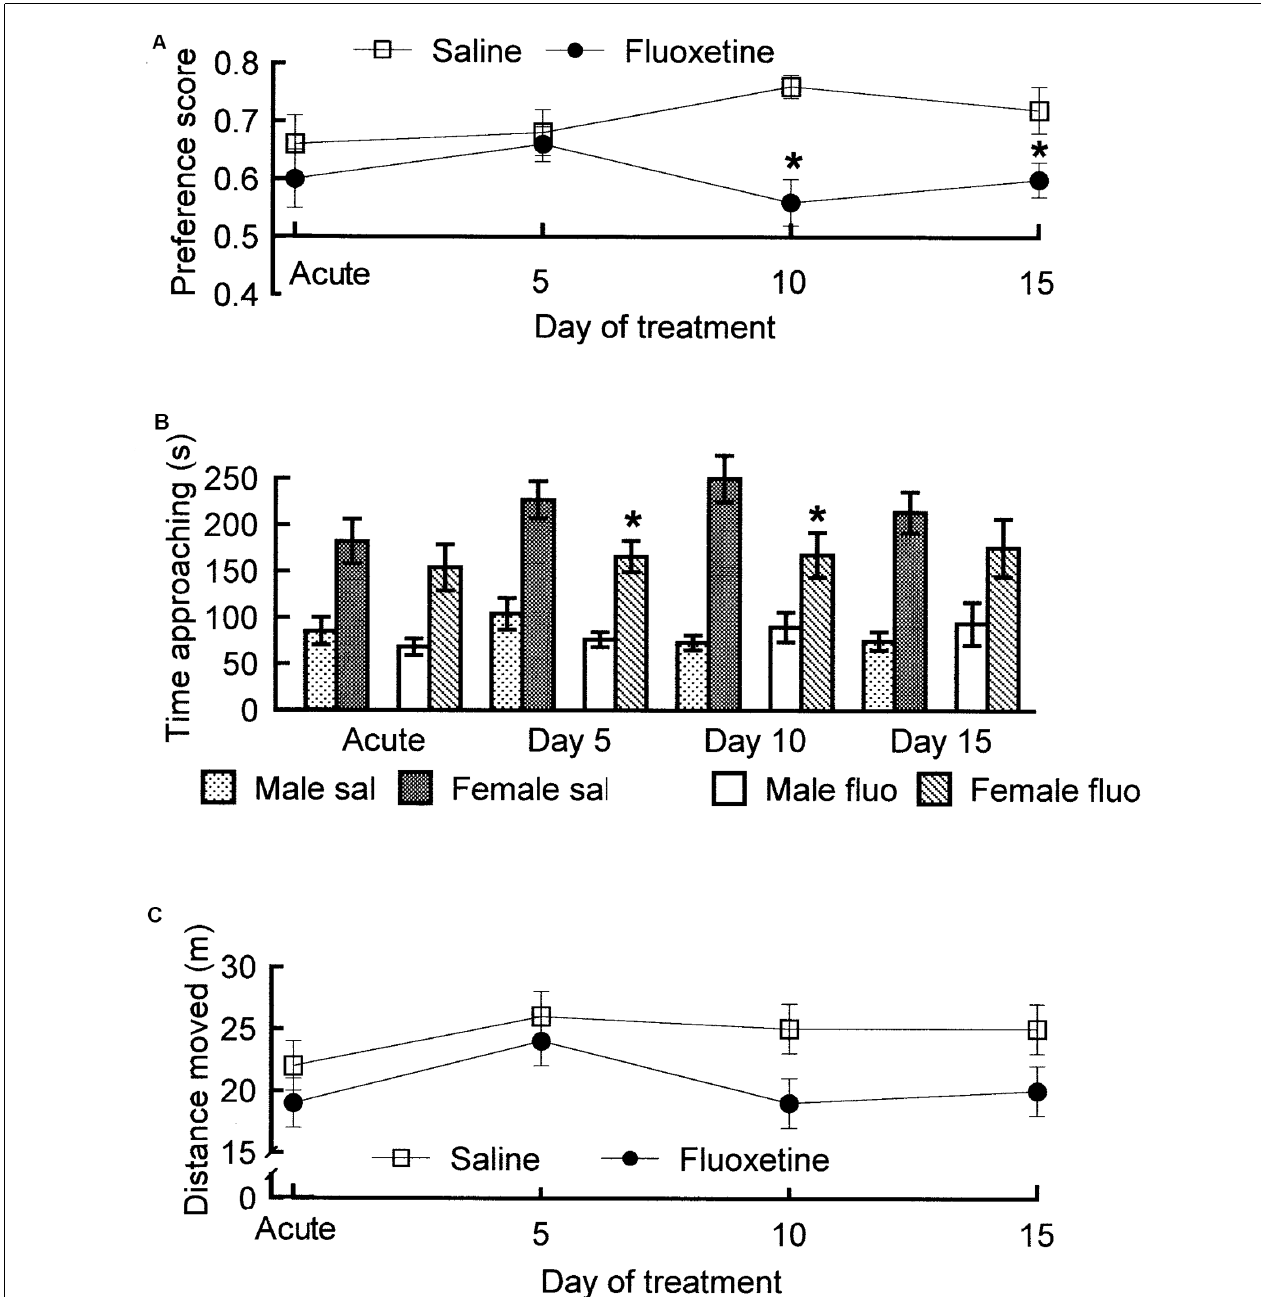
FIGURE 9 | The effects of fluoxetine, 10 mg/kg and day given orally, on sexual approach behaviors in male rats. The procedure described in “Sexual Approach in Rodents” section was used. Test duration was 10 min. The acute test was performed 60 min after drug administration. (A) Preference score. Mixed two-factor ANOVA with Treatment and Day as factors revealed a significant Treatment effect ( F ( 1,34 ) = 7.528, p = 0.010), but there was no effect of Day ( F ( 3,102 ) = 0.192, p = 0.902) and no interaction Treatment × Day ( F ( 3,102 ) = 1.239, p = 0.300). (B) Time spent in the vicinity of the social incentive (another male) and in the vicinity of the sexual incentive (receptive female rat). Three-factor ANOVA with the factors Incentive, Treatment and Day found an effect of Incentive ( F ( 1,34 ) = 86.072, p < 0.001) and of Treatment ( F ( 1,34 ) = 7.134, p = 0.012) but not of Day ( F ( 3,102 ) = 1.789, p = 0.154). The time spent in the vicinity of the female was superior to that spent in the vicinity of the social incentive at all tests according to the Tukey HSD test. There was also an interaction between Incentive and Treatment ( F ( 1,34 ) = 7.993, p = 0.008). Fluoxetine did not alter the time spent in the vicinity of the male incentive whereas the time spent in the vicinity of the sexual incentive was reduced. There were no other interactions ( p s > 0.300). Thus, fluoxetine did not modify social approach but reduced sexual approach. Since there was no interaction Treatment × Day, this effect was present already at the acute test. (C) The distance moved during the test, a measure of ambulatory activity, was not altered by treatment and did not vary between days ( p s > 0.102). Thus, the inhibition of sexual approach cannot be explained as a secondary effect of reduced activity. Data are mean ± SEM. ∗ Different from saline, p < 0.05. From an unpublished experiment performed by AÅ, Juoni Sirviö, Gro Sandberg and Live Sørensen.